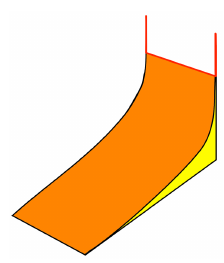
Figure 7 . A cartoon of the trailing wall and its boundaries in the thinnest-wall limit at t (cid:29) t n . In red the rectangular D 8 whose horizontal part insists on the